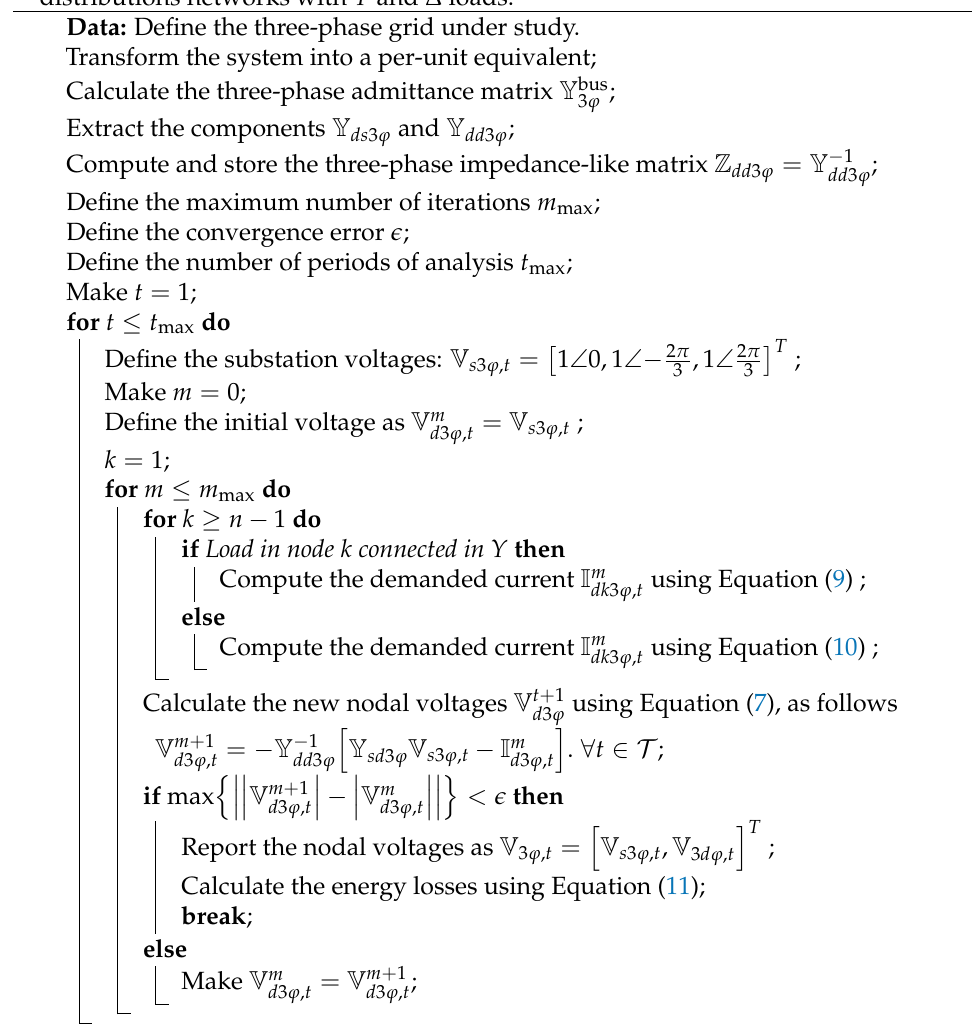
Algorithm 1: Solution of the three-phase power flow problem for unbalanced distributions networks with Y and ∆ loads.